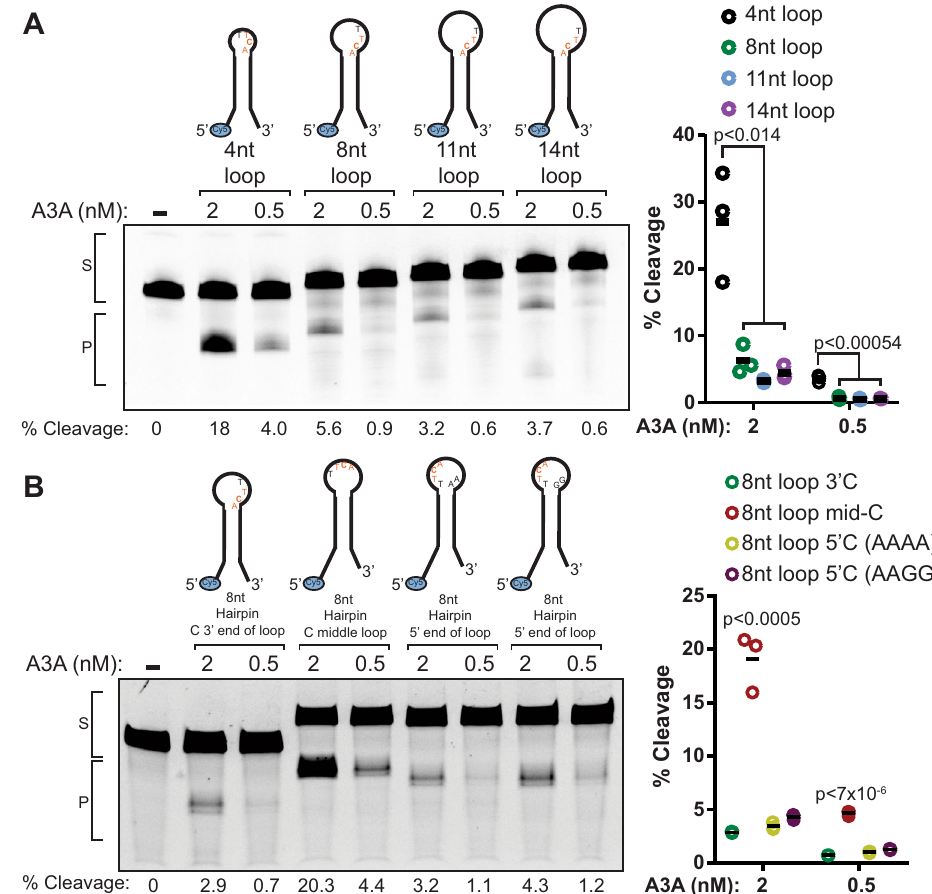
Figure 2. APOBEC3A prefers stem loops with 4nt loops, and target C in the middle of the loop. ( A ) Deaminase assay of 2 nM A3A, 0.5 nM A3A or no A3A incubated with 100 nM hairpins with 4, 8, 11, or 14 nt loops for 1 h at 37 °C before processing as in Fig. 1C. ( B ) Deaminase assay as in ( A ) using 8 nt hairpins with the target C in the 3 ′ -most (8nt loop 3 ′ C), middle (8nt loop mid-C), or 5 ′ -most (8nt loop 5 ′ C) position in the loop for 3 h at 37 °C before processing as in Fig. 1C. Two versions of the 8nt loop 5 ′ C hairpin are included, where the sequence of the 3 ′ portion of the loop is either AAAA [8nt loop 5 ′ C (AAAA)] or AAGG [8nt loop 5 ′ C (AAGG)]. S denotes substrate band; P denotes the product band. Full-length gel images for 2A and 2B are presented in Fig. S5. Quantifications of the percent cleavage for 3 replicate experiments of ( A ) and ( B ) are shown. Horizontal bars indicate mean values. P-values were determined by